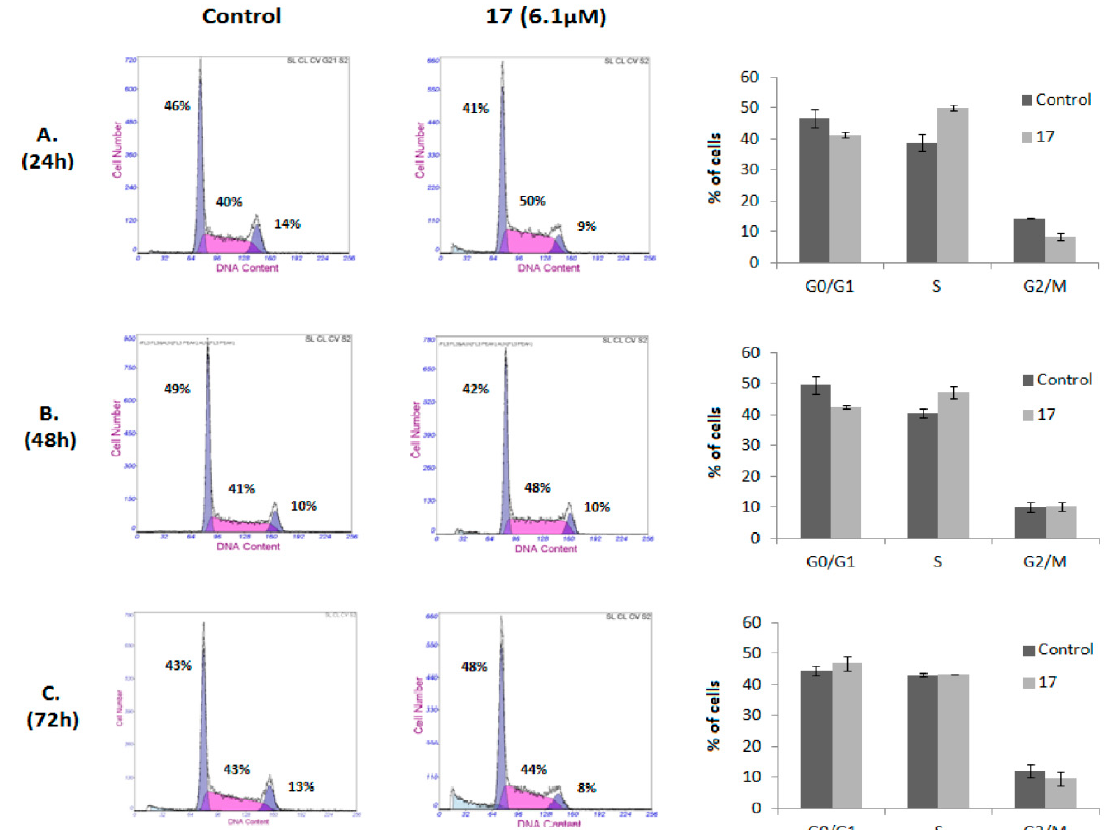
Figure 1. Effect of compound 17 on cell cycle distribution. Cell cycle analysis of Jurkat cells untreated (Control) or treated with 6.1 µ M compound 17 for 24 h ( A ), 48 h ( B ), and 72 h ( C ). After treatment, cells were stained with PI and DNA content analyzed by flow cytometry. A representative histogram is shown for each incubation time and condition. Results are presented as means ± SD of three independent experiments.